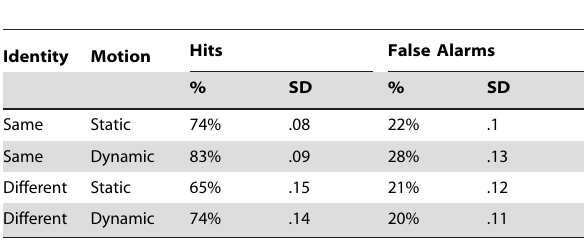
Table 1. Hit and False Alarm rates by identity and motion